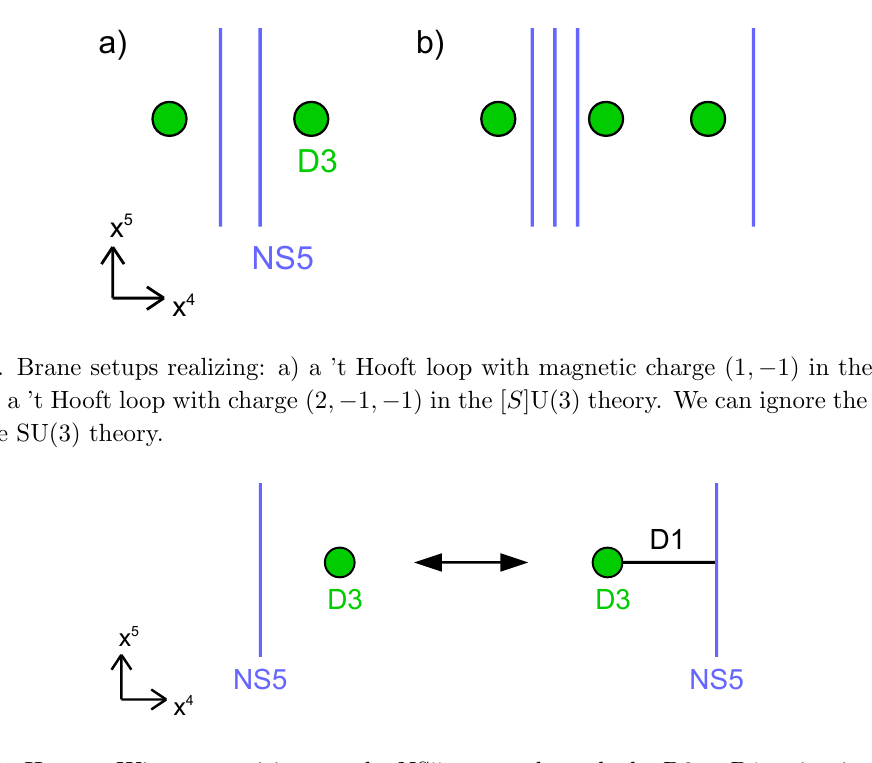
Figure 2 . Hanany-Witten transition: as the NS5 passes through the D3, a D1 string is created. (since it can be measured \at in(cid:12)nity" on the D3 worldvolume and does not depend on the local NS5 crossing. If we denote by Q , respectively (cid:0) Q , the magnetic charge that the NS5 induces on the D3 brane when it is on its right, respectively on its left, we (cid:12)nd that the magnetic charge conservation in the Hanany-Witten transition satis(cid:12)es Q = 1 (cid:0) Q , namely Q = 1 . This justi(cid:12)es the claim above that the NS5 induces a ’t Hooft loop with magnetic 2 charge (cid:6) 1 for each D3 2